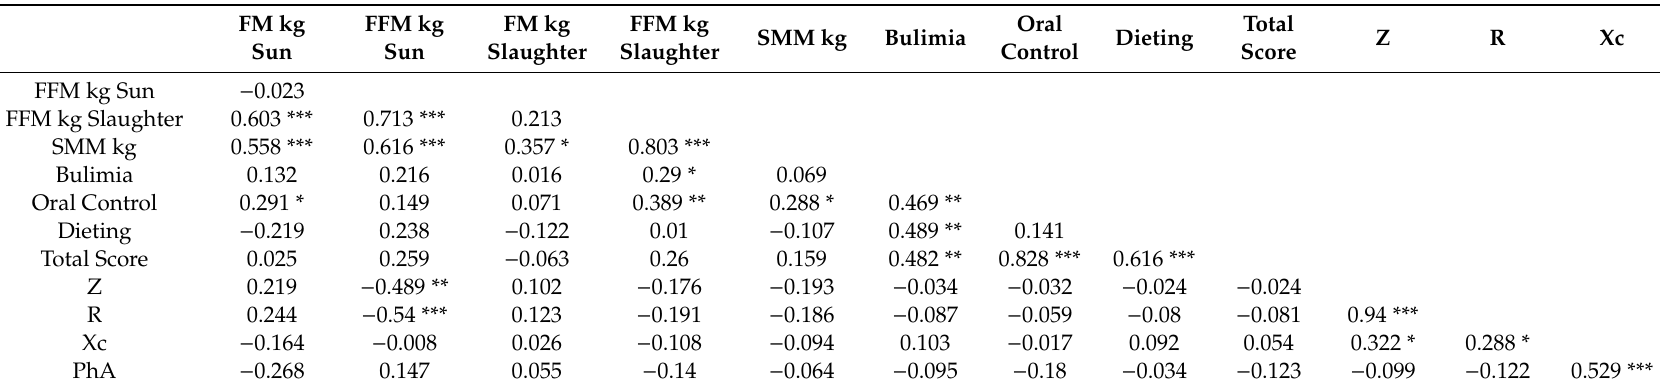
Table 3. Spearman’s rank correlation coe ffi cients between body composition and BIA variables with subescales EAT-26 in Advanced Training